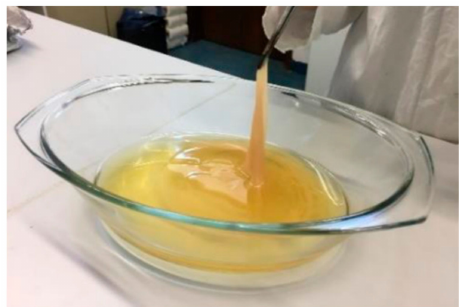
Figure 3. Static production of cellulose by Komagataeibacter maltaceti 1529 T on complex microbiological medium. Table 1. The most common methods for bacterial cellulose (BC) production. Basic Characteristics of The Process Method for BC Production